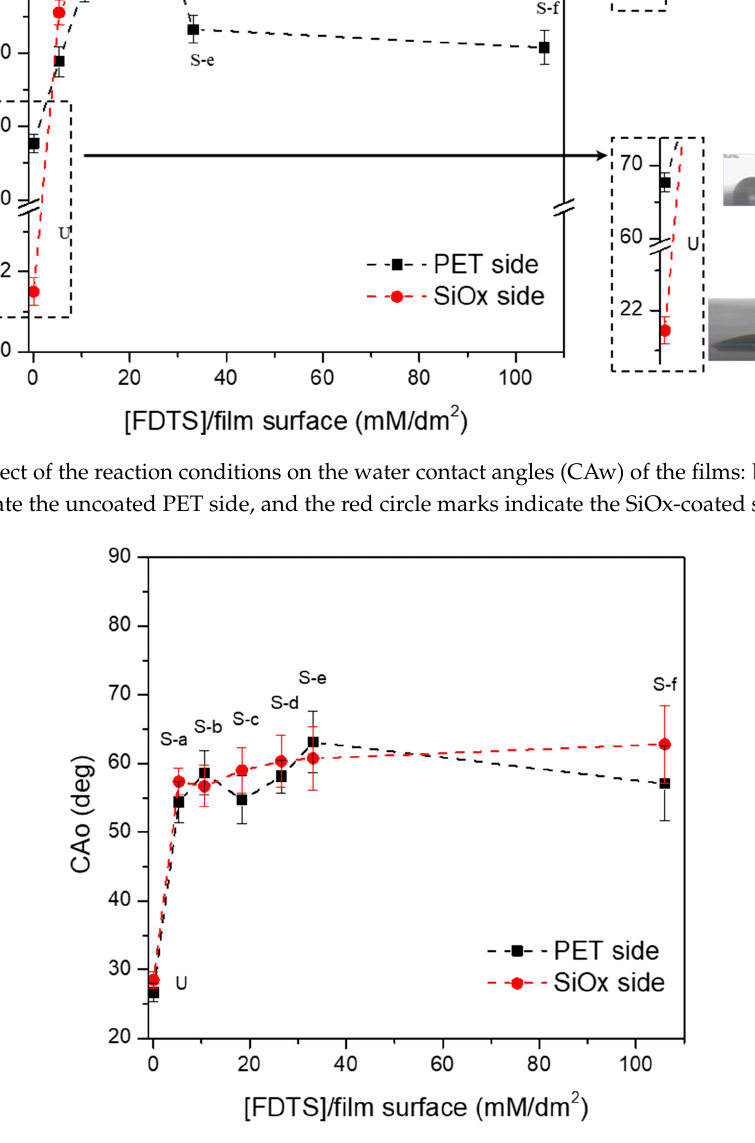
Figure 6. Effect of the reaction conditions on the oil contact angles (CAo) of the films: black square marks indicate the uncoated PET side, and the red circle marks SiOx-coated side.